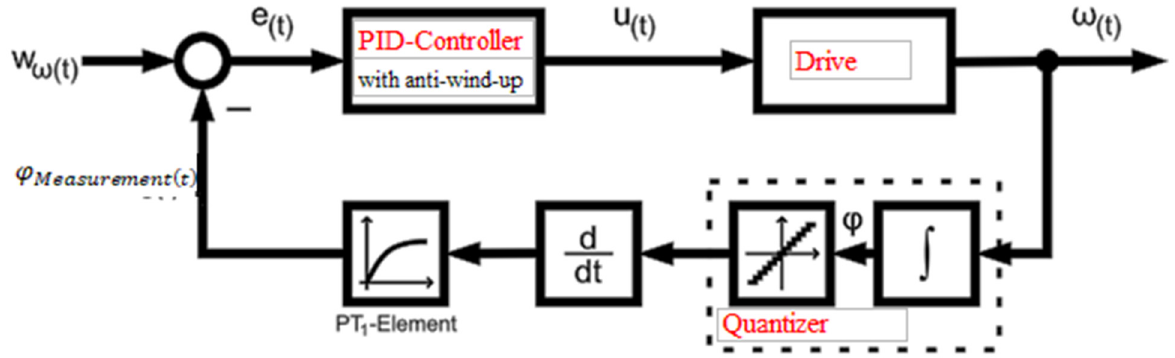
Figure 4. The speed control circuit of the drive train.